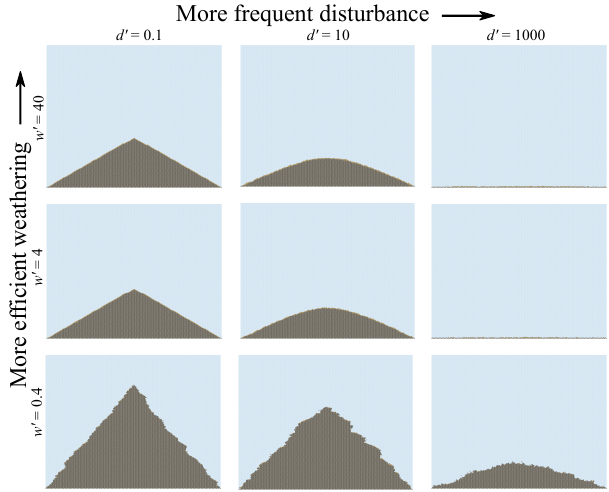
Figure 11. Final equilibrium profiles from Grain Hill runs with rock and weathering. Domain size is 222 rows by 257 columns, and uplift interval ranges from 100 to 10000